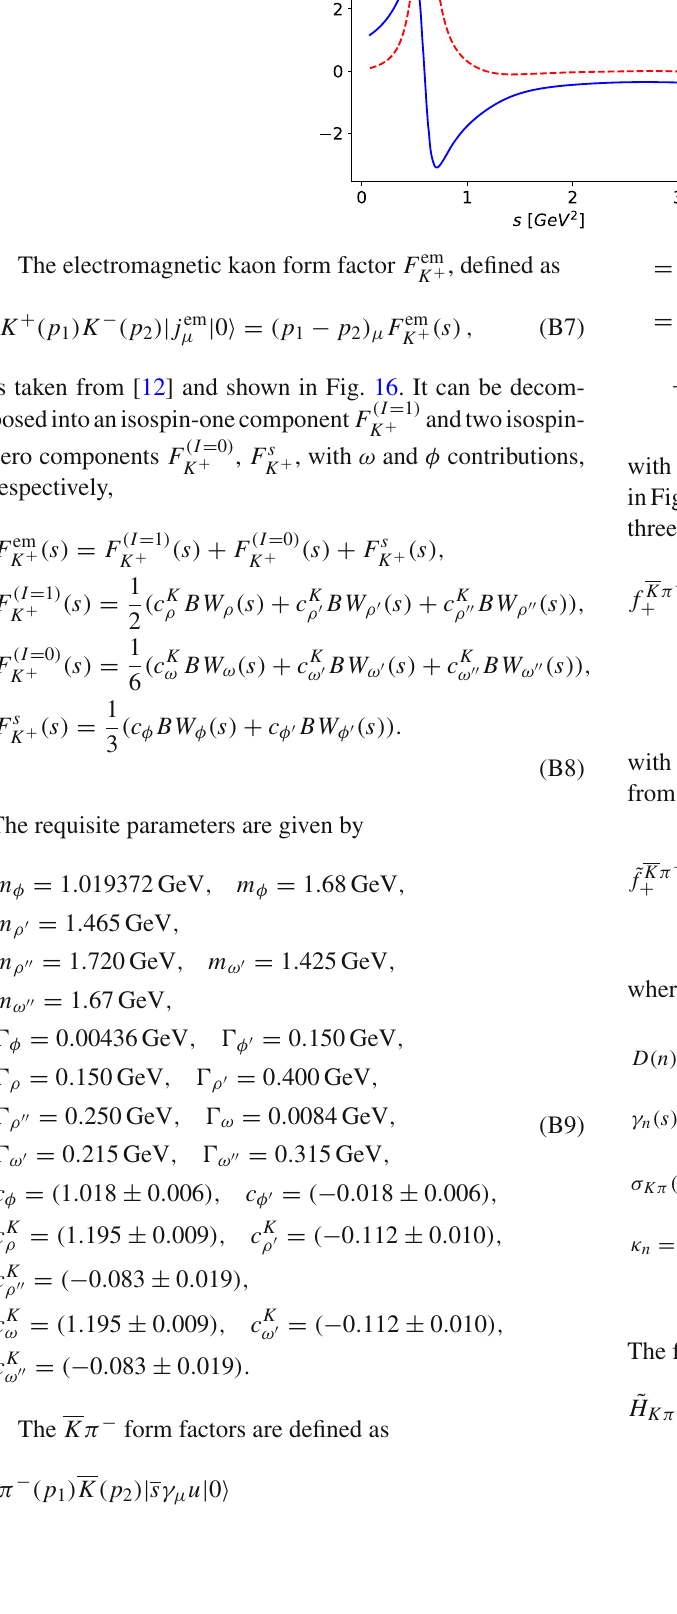
Fig. 15 The real and imaginary part of the electromagnetic form factor F em π (B3) (left) as well as the absolute value (right) as a function of the invariant mass squared